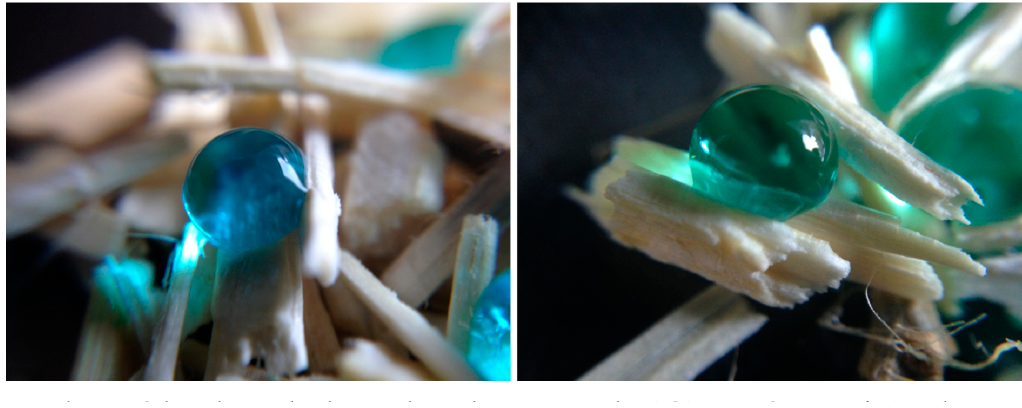
Figure 8. Coloured water droplets onto hemp shiv H12-1-5, with a WCA > 125°. Courtesy of TWI